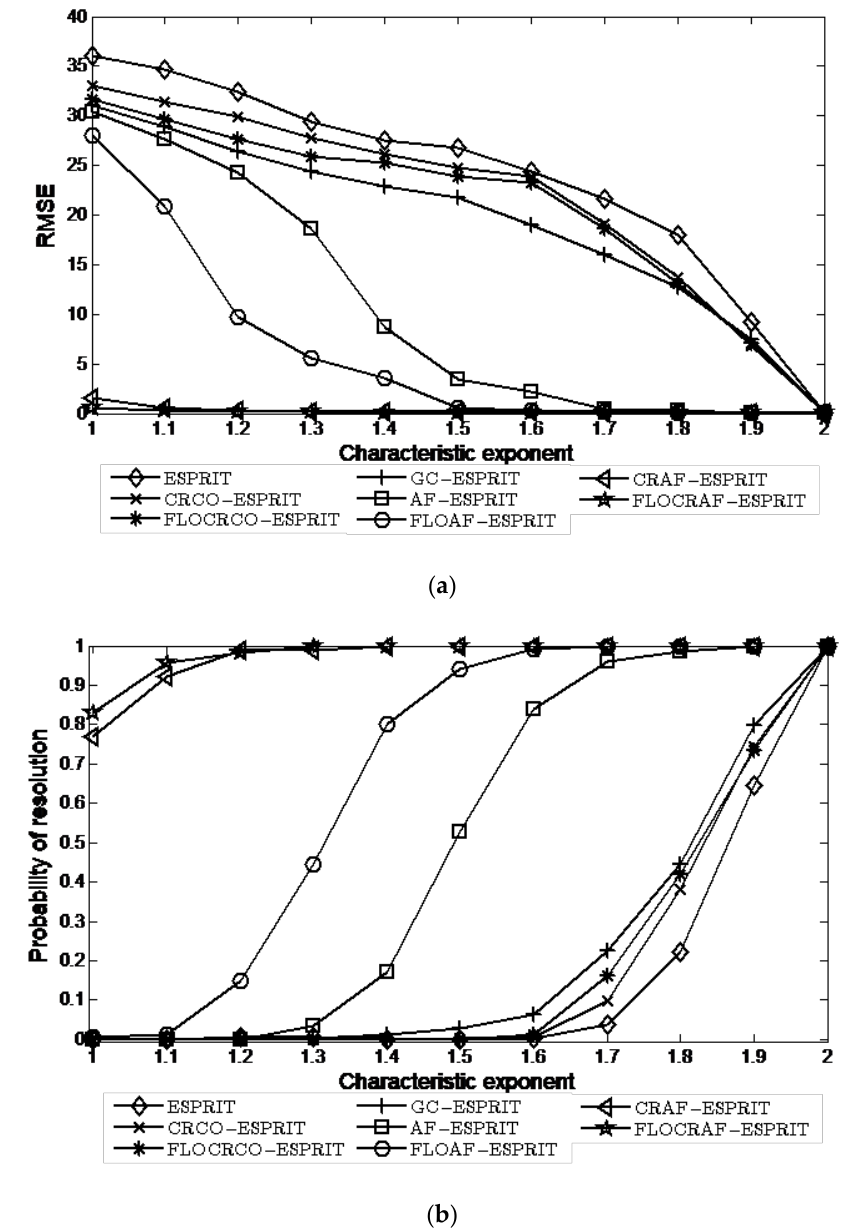
Figure 5. Performance vs characteristic exponent ( GSNR = 5 dB ): ( a ) RMSE; ( b ) Probability of resolution.